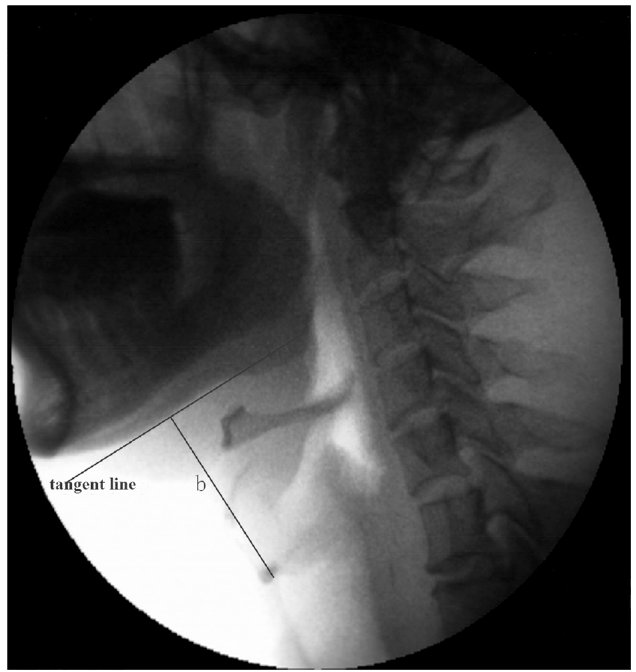
Fig 1. Lateral view of a videofluoroscopic image, showing the tangent line at the laryngeal rest position. The line b, perpendicular to the tangent line, illustrates the distance between the larynx and